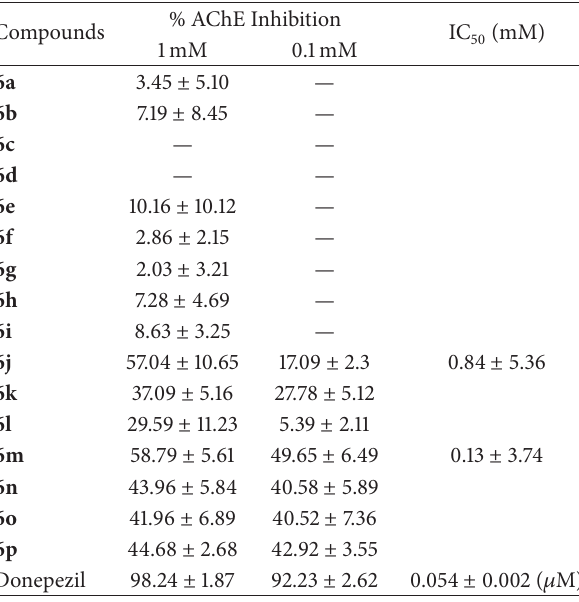
Table 2: % AChE inbition of the compounds 6a – 6p and IC